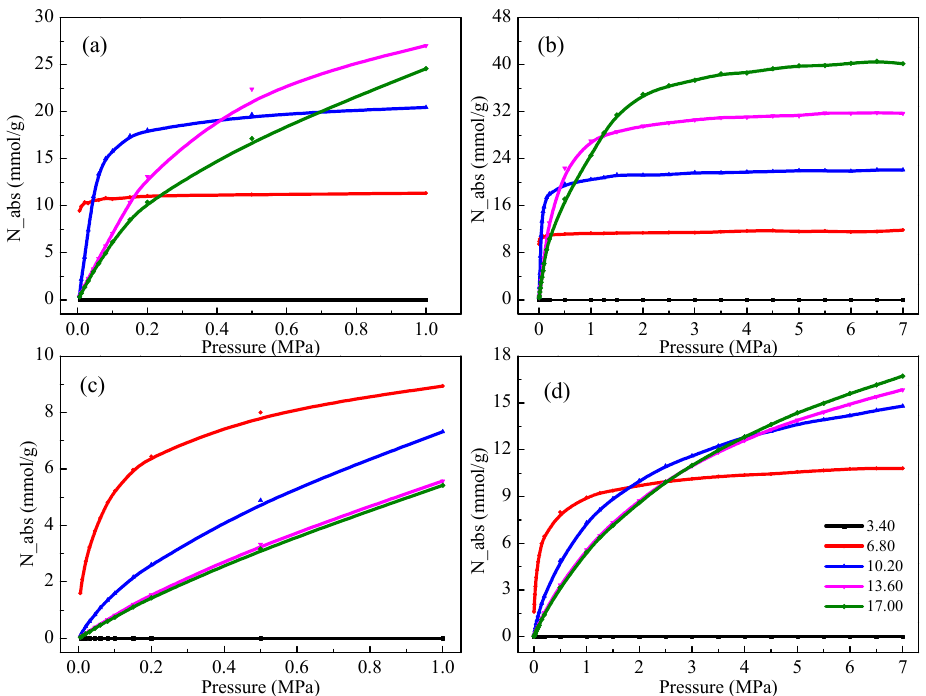
Figure 4. The absolute adsorption isotherms of CO 2 ( a , b ) and N 2 ( c , d ) at low and high pressure and 298 K.